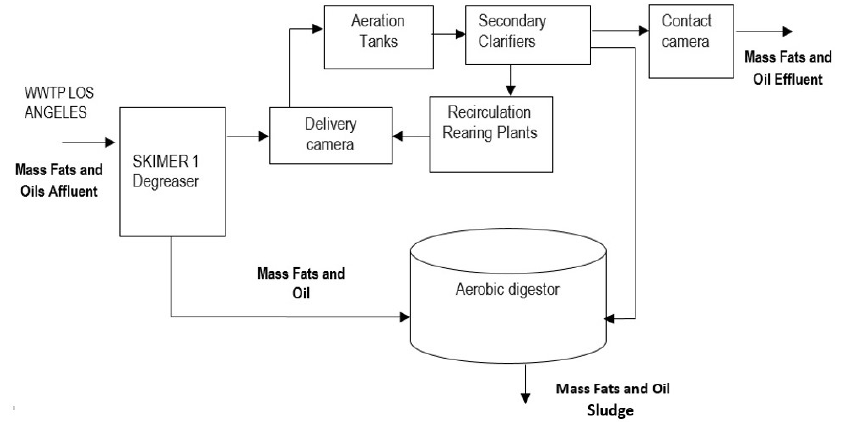
Figure 4. General flow diagram of the Los Angeles WWTP.